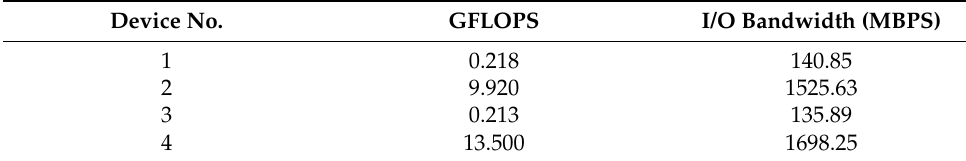
Table 6. Performance parameters of edge devices in experiments on B-ResNet. Device No.